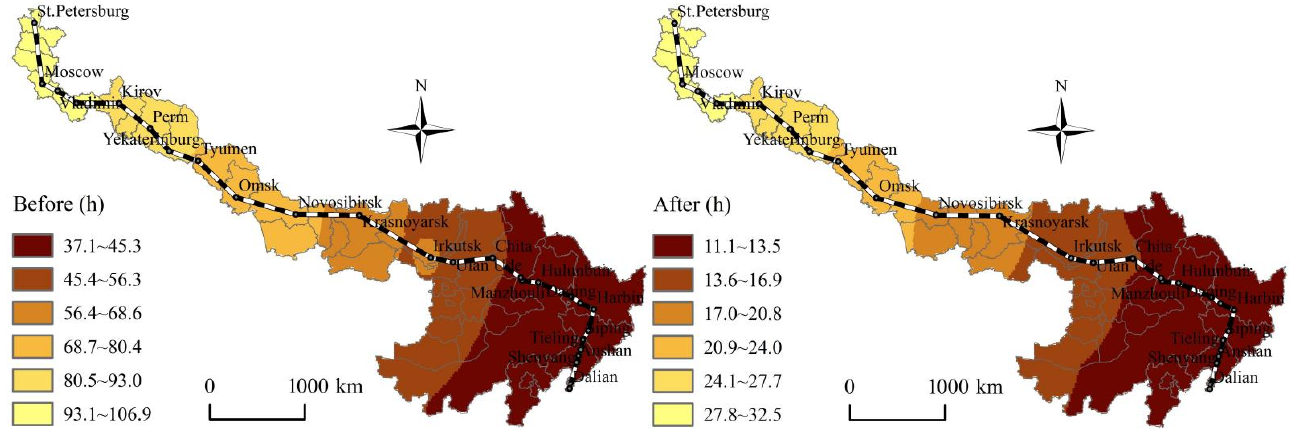
Figure 3. Spatial pattern changes of the economic potential before and after the China-Mongolia- Russia HSR west line opening.